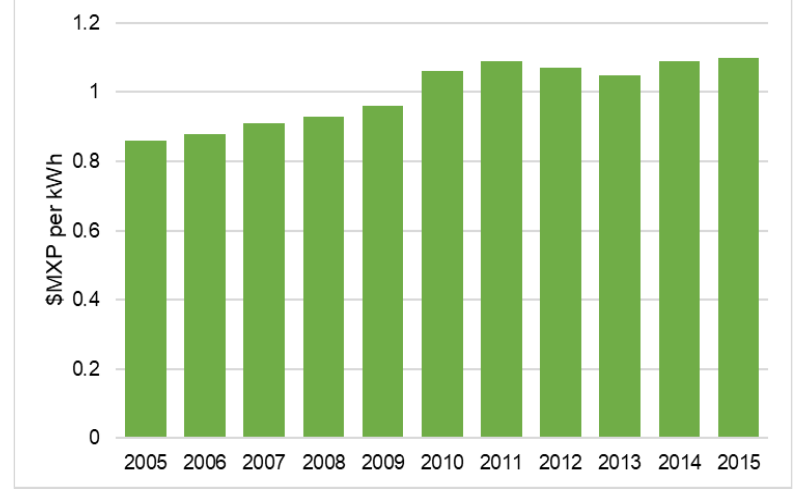
Fig. 2. Electricity price in 2015 $MXP, 2005–2015 (SENER,